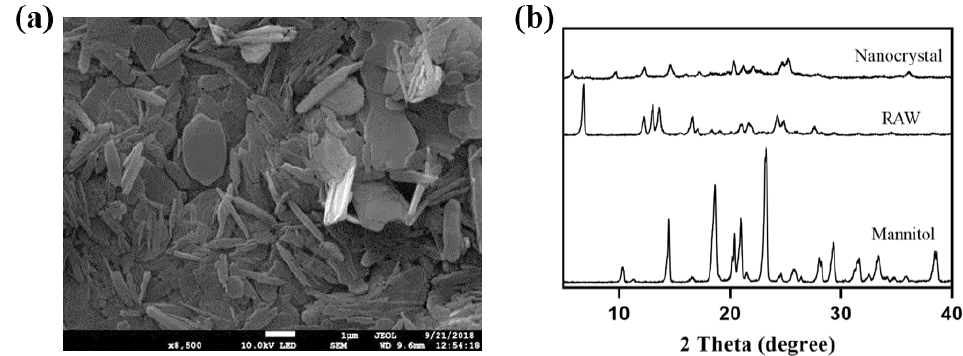
Figure 10. SEM image ( a ) and XRD results ( b ) of nanocrystals obtained by lyophilization.